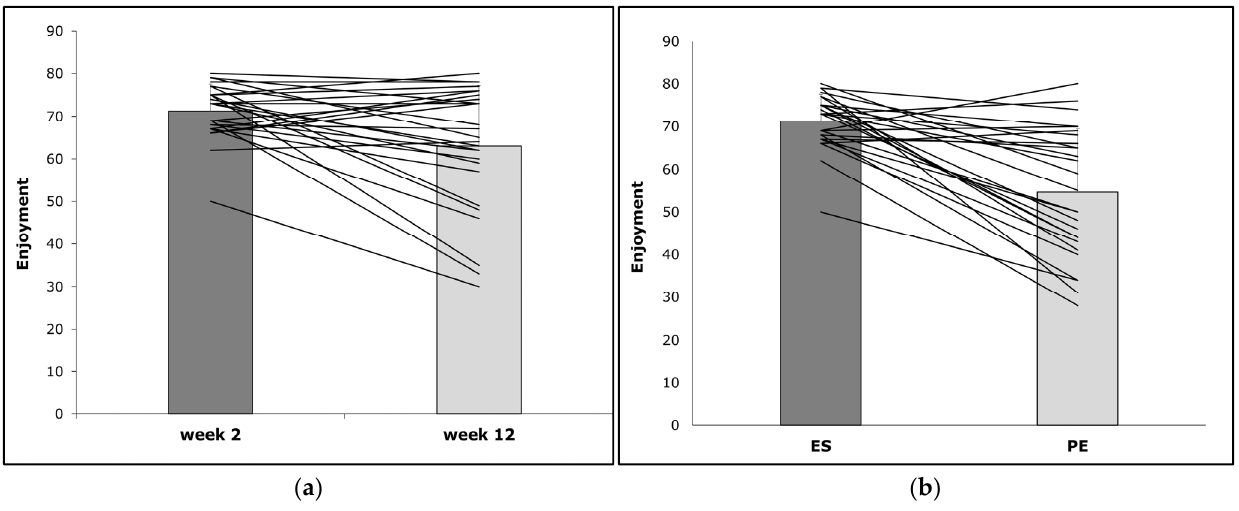
Figure 2. ( a ) Perceived enjoyment during an exergaming session in weeks two and 12; ( b ) Perceived enjoyment during an exergaming session and a PE class in week two. In both figures, the bars show the mean Physical Activity Enjoyment Scale (PACES)-scores. The lines represent individual changes.